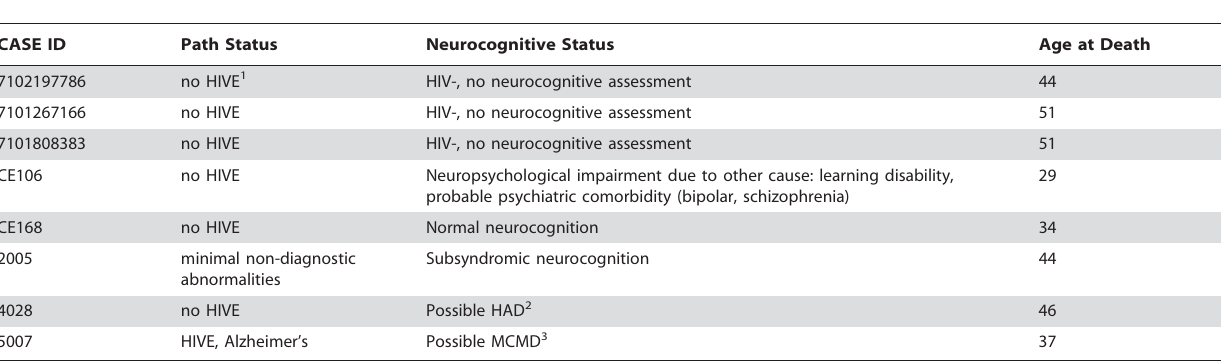
Table 1. Post-mortem brain tissues received from the National NeuroAIDS Tissue Consortium.